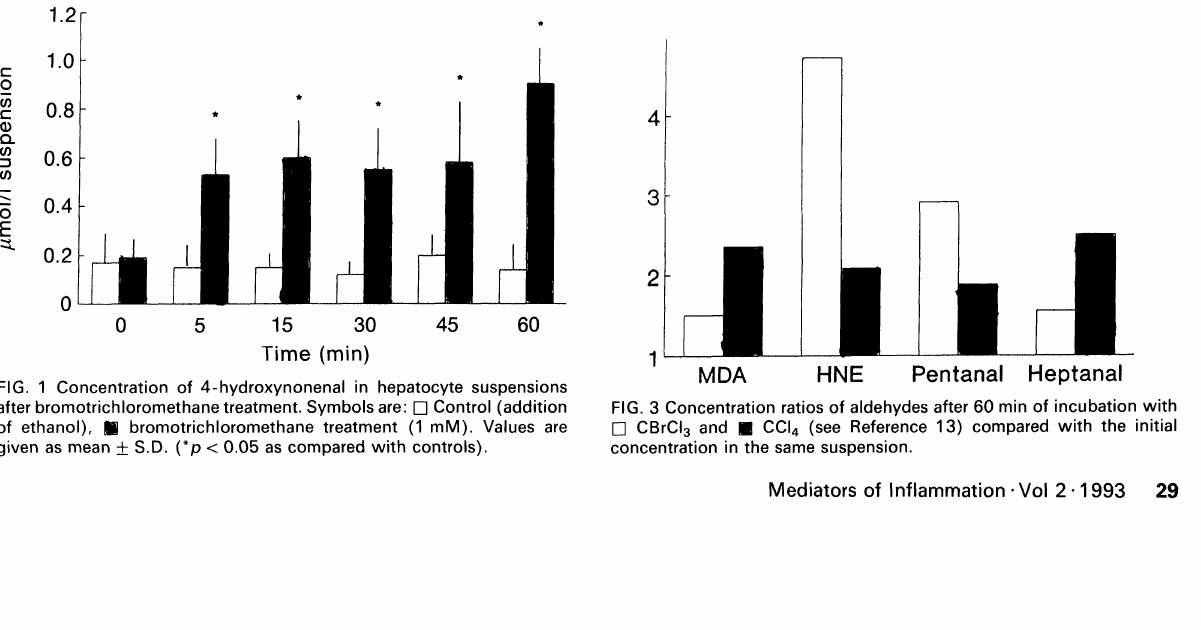
Concentration of 4-hydroxynonenal in hepatocyte suspensions after bromotrichloromethane treatment. Symbols are: [] Control (addition of ethanol), I bromotrichloromethane treatment (1 mM). Values are given as mean -t-_ S.D. (*p < 0.05 as compared with controls).